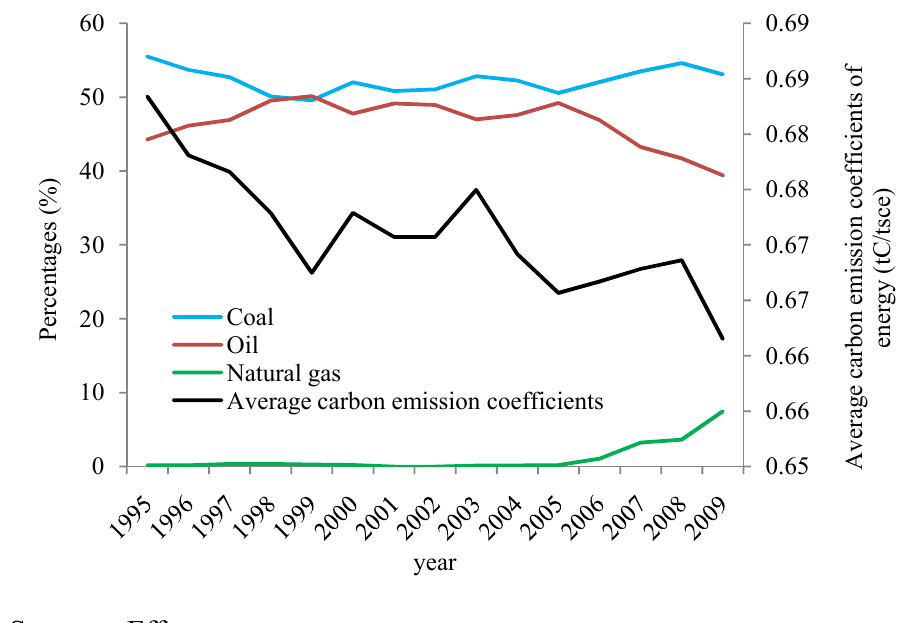
Figure 7. Energy mix and average carbon emission coefficients of